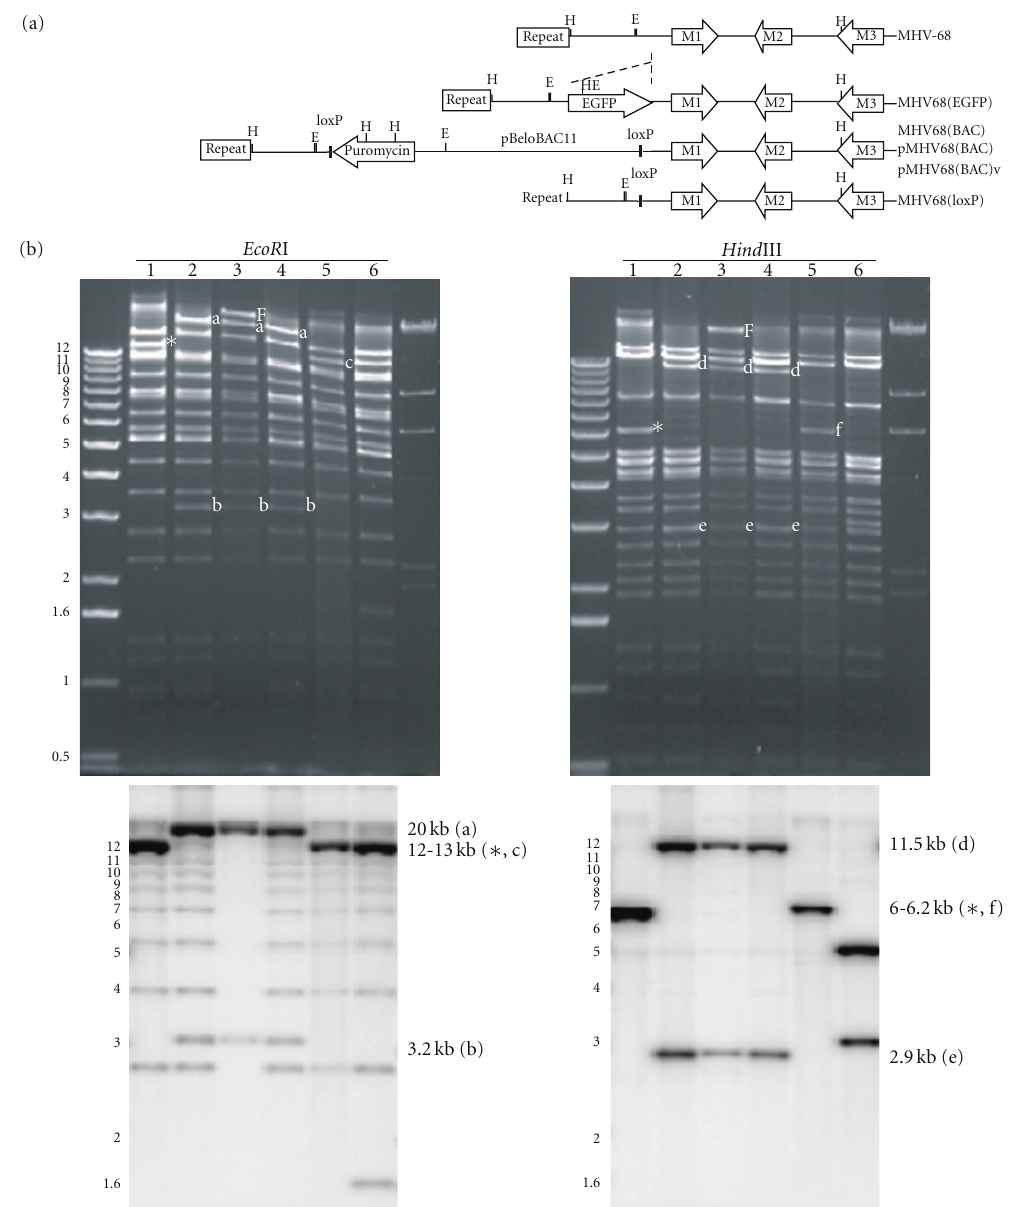
Figure 1: The genomic structures of the MHV-68 recombinant viruses and the MHV-68 BAC plasmid. (a) Schematic diagram of the construction of the MHV-68 BAC virus. Shown is the left end of the viral genome encompassing terminal repeats and ORFs M1–M3. The BAC vector sequence and a puromycin expression cassette was recombined into the locus where the EGFP expression cassette was inserted in MHV-68(EGFP). MHV-68(BAC) was selected for the loss of the EGFP expression. The pMHV-68(BAC) plasmid was obtained by electroporating the circular genome of MHV-68(BAC) into DH10B cells. Following transfection of pMHV-68(BAC) into BHK-21 cells, the reconstituted virus, pMHV-68(BAC)v, was generated. The structures of pMHV-68(BAC) and pMHV-68(BAC)v are identical to MHV- 68(BAC), except that pMHV-68(BAC) is circular with termini fused. To remove the BAC insert flanking by loxP sites, pMHV-68(BAC)v was co-transfected with a Cre recombinase expression plasmid and MHV-68(loxP) was isolated. The sites of Hind III are indicated with H and the ones of EcoR I were indicated with E. (b) Restriction enzyme analysis of the genome of MHV-68 recombinant viruses and the MHV-68 BAC plasmid. Each DNA sample was digested with either EcoR I or Hind III. Lane 1 is virion DNA of wild-type MHV-68; lane 2 is virion DNA of MHV-68(BAC); lane 3 is the plasmid DNA of pMHV-68(BAC); lane 4 is virion DNA of pMHV-68(BAC)v; lane 5 is virion DNA of MHV-68(loxP) and lane 6 is virion DNA of MHV-68(EGFP). The wild-type fragments which were eliminated due to the insertion of the BAC sequence were marked with asterisks. The fragments marked with a, b, d, and e, were generated because of the BAC insert. The fragments marked with c and f, resulted from the removal of BAC, 200bp larger than the fragments indicated with asterisks. The fragments marked with F were from the fused termini of the circular pMHV-68(BAC). On the bottom of each agarose gel picture is the corresponding Southern blot using the probe spanning nt 51–6298. The laddering patterns in EcoR I-digested samples were due to various number of repeats on the linear virion DNA but not present in pMHV-68(BAC) (lane